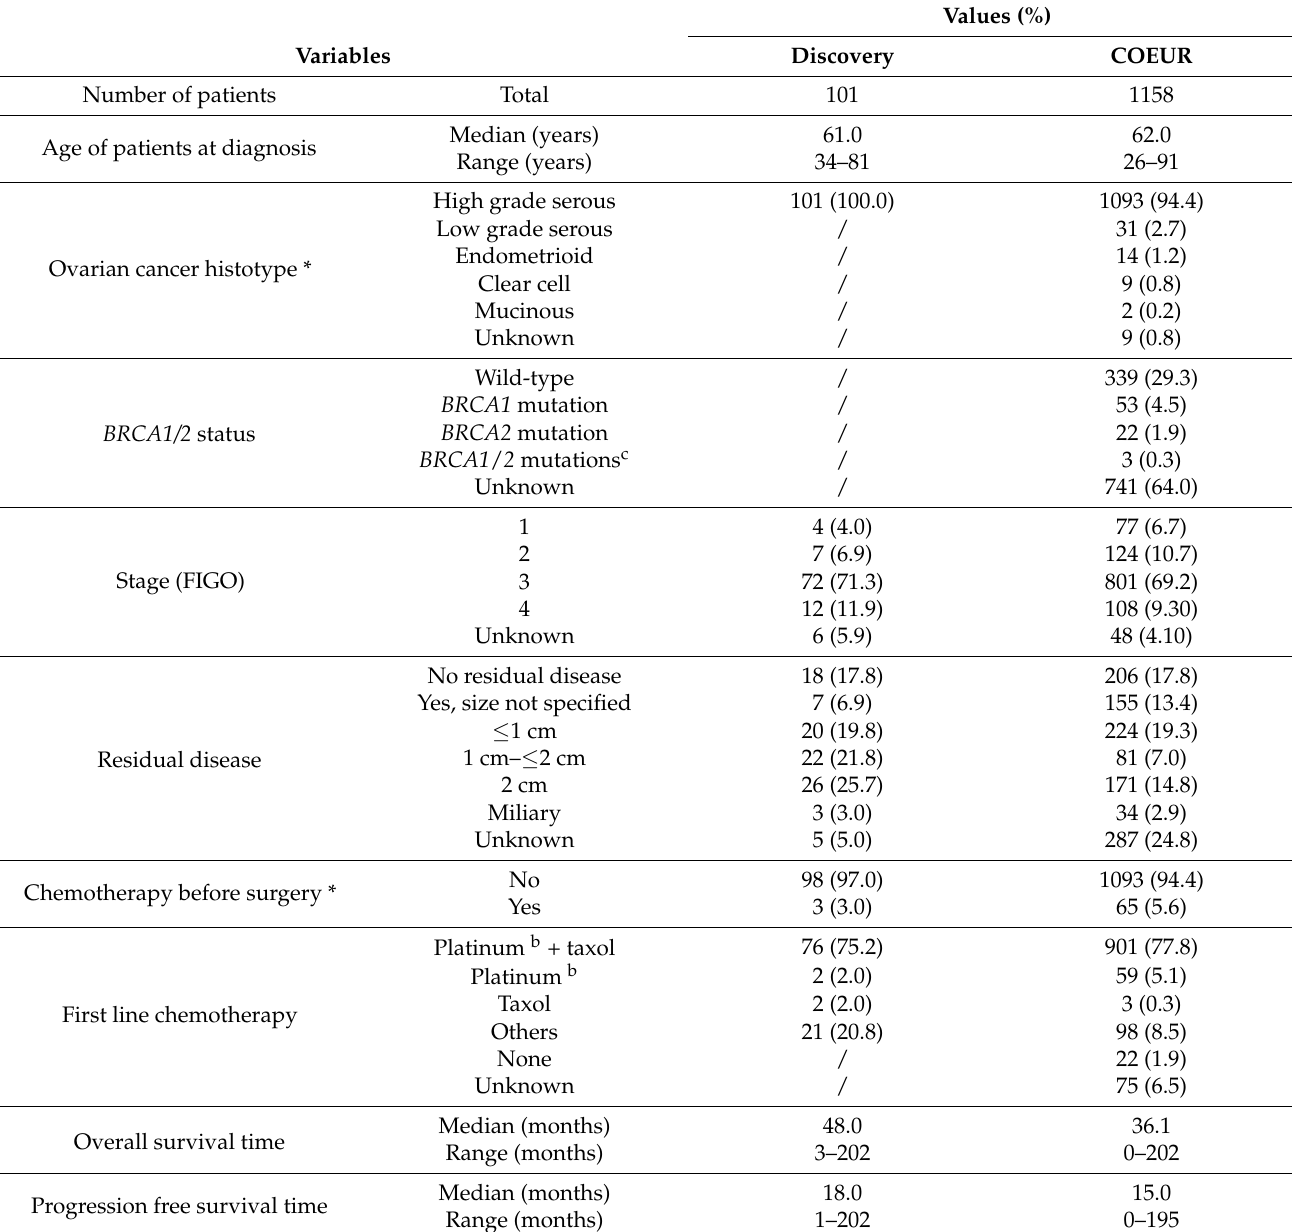
Table 1. Clinicopathological characteristics of the discovery and COEUR